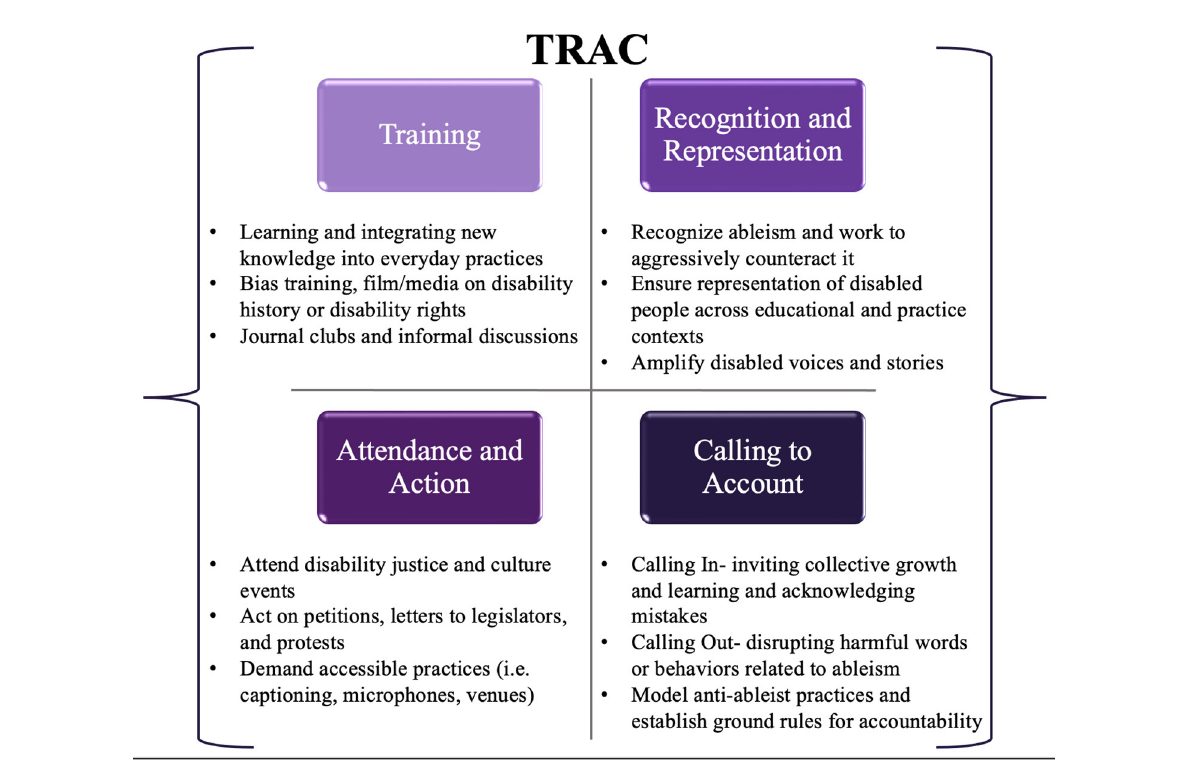
FIGURE3 TRAC mnemonic for engaging in disability allyship: Training, Recognition and Representation, Attendance and Action, and Calling to